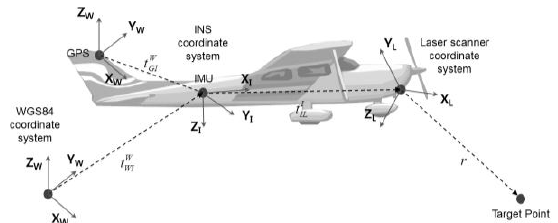
Figure 5. Geometric relationships of lidar (Schenk,